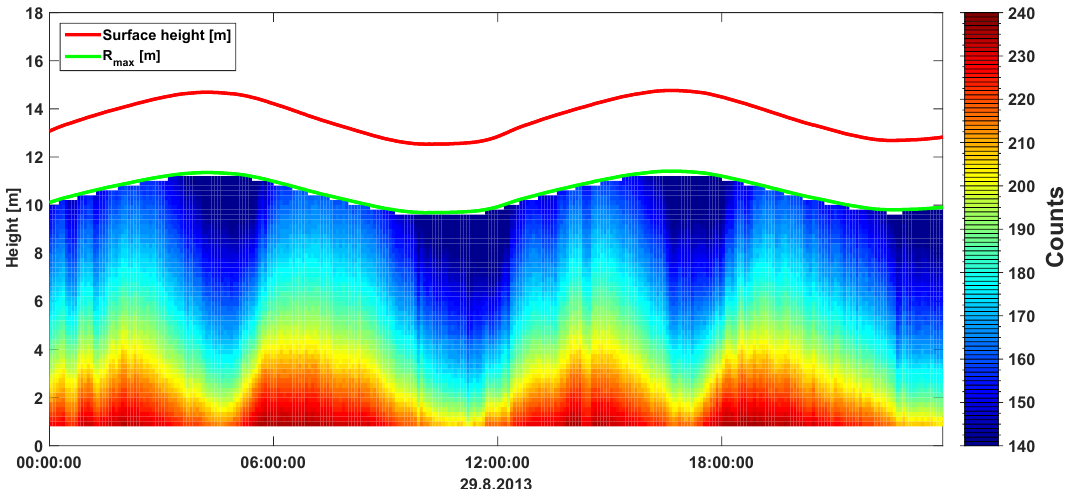
Figure 3. An example of acoustic backscatter signal in counts measured with the ADCP (from the seafloor upwards through the water column), acceptable backscatter data until R max . Green line: R max depth in metres; red line: sea level (height in metres) observed on 29 August 2013.